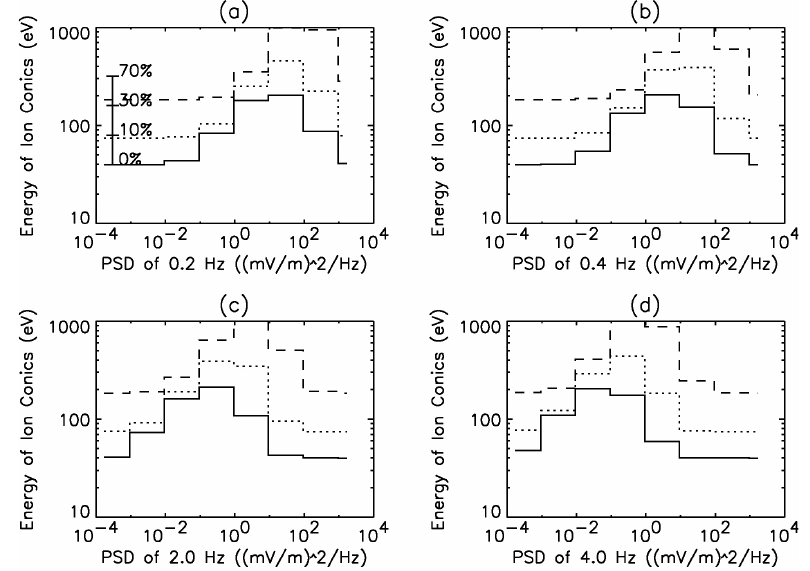
Fig. 3. Histograms of power spectral density of LEFs associated with ion conics. Solid, dotted, and broken lines represent histograms of power spectral density associated with ion conics within energy ranges of 30–50eV, 50–100eV, and more than 100eV, respectively. Occurrence is normalized to give a total of 100% in each histogram.